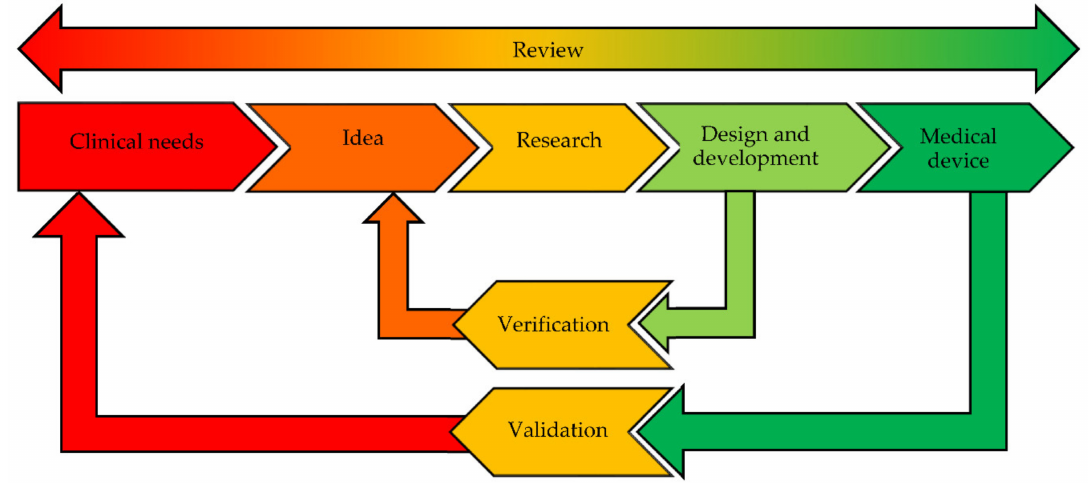
Figure 7. Design control documentation, evidence, and results in the life cycle for medical devices. Modified from [201] with